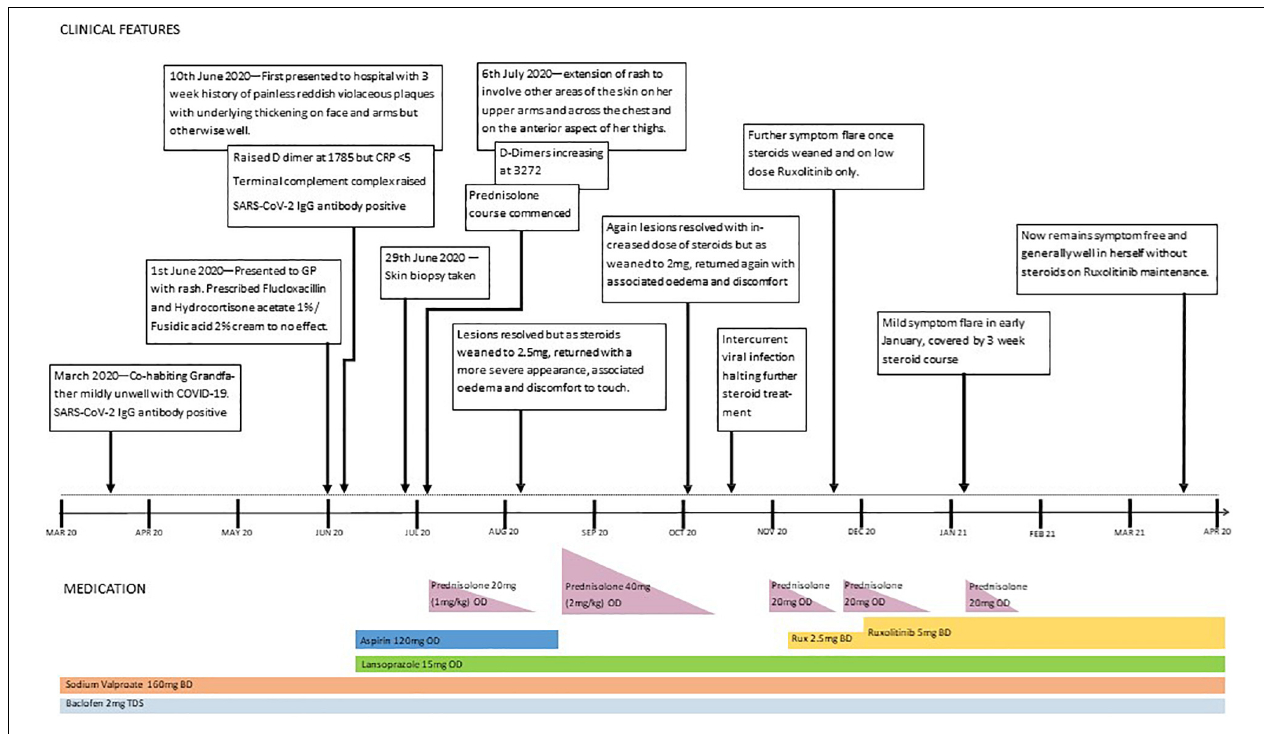
FIGURE 3 | Timeline with the most relevant data of the clinical